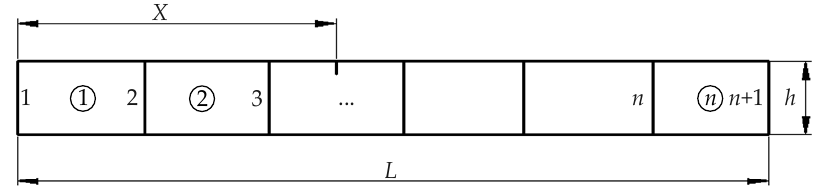
Figure 5. Discretization of the beam with the breathing crack.